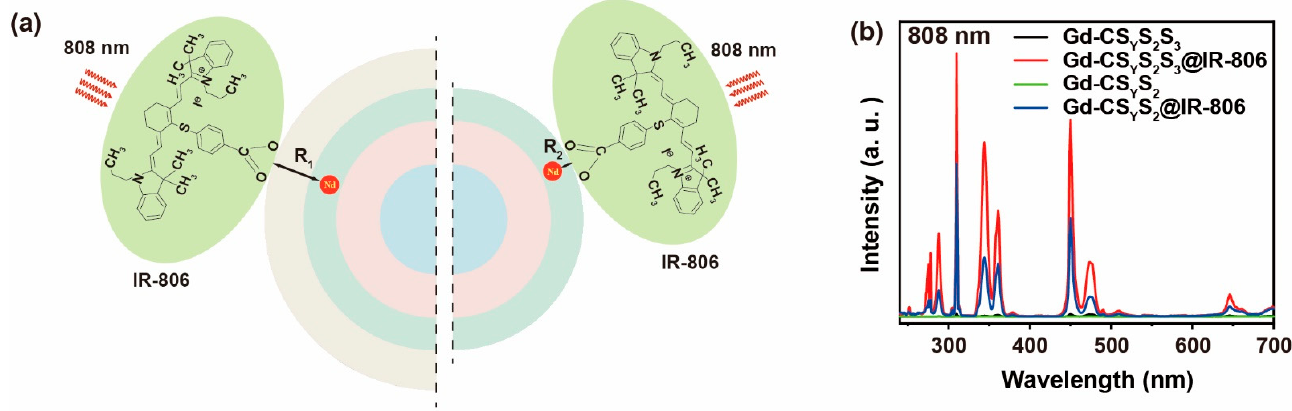
Figure 4. The effect of the distance between IR ‐ 806 and sensitizer Nd 3+ on upconversion emission. ( a ) Schematic illustration of the nanostructural design to study the distance effect on upconversion emission. ( b ) The emission spectra of Gd ‐ CS Y S 2 S 3 , Gd ‐ CS Y S 2 S 3 @IR ‐ 806, Gd ‐ CS Y S 2 , Gd ‐ CS Y S 2 @IR ‐ 806 under 808 nm excitation.